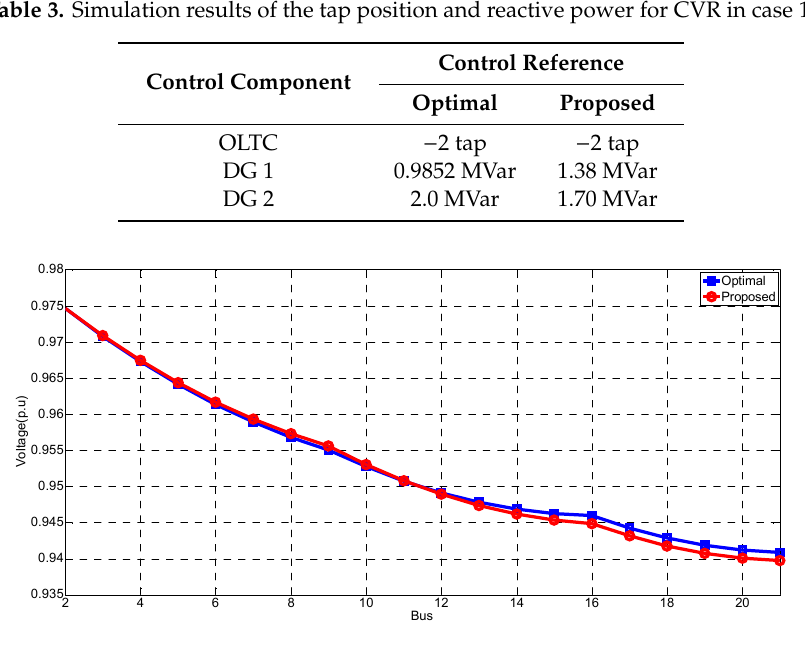
Figure 19. Comparison of results for CVR in case 1.